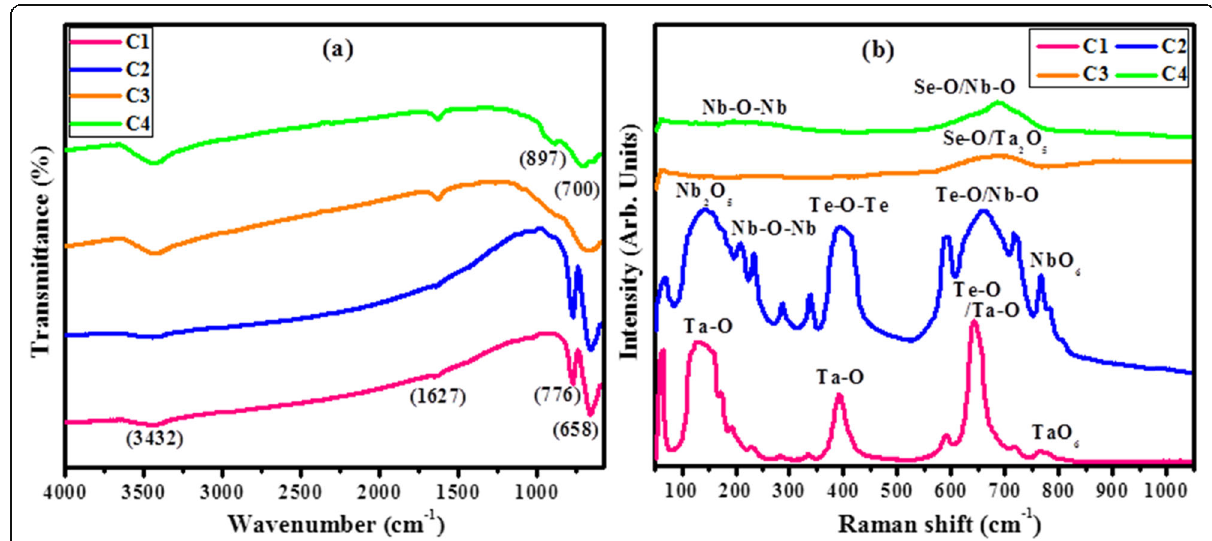
Fig. 6 a FTIR spectra. b Raman spectra of C1, C2, C3, and